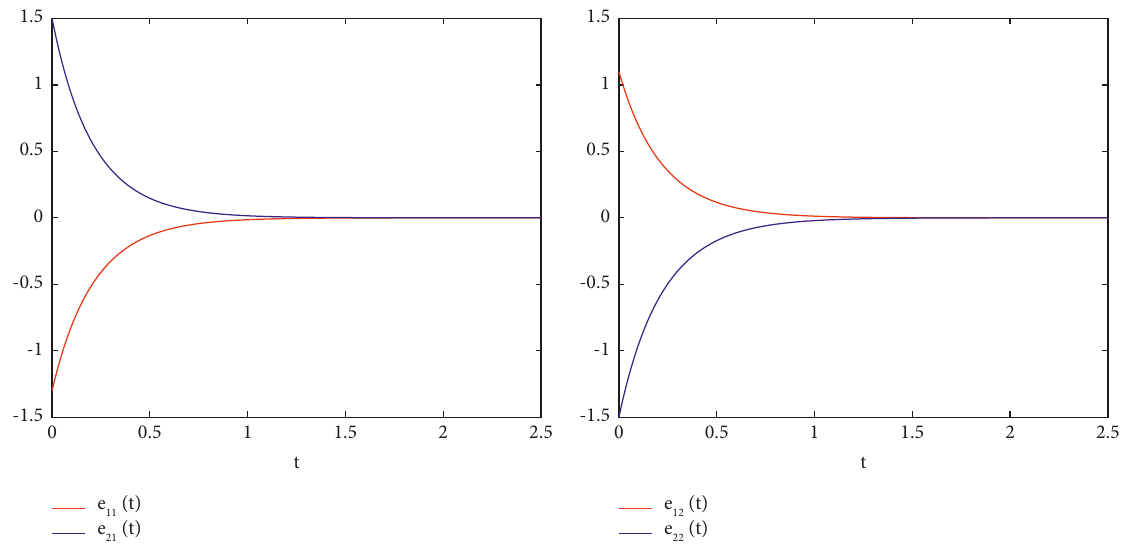
Figure 4: The evolvement behavior of error system (81) under a linear control